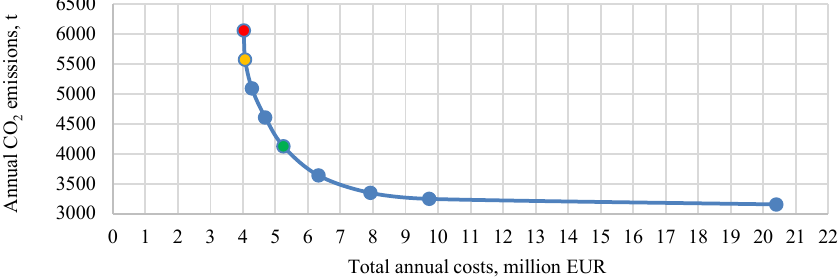
Fig. 6. Pareto frontier of annual CO 2 emissions and total annual